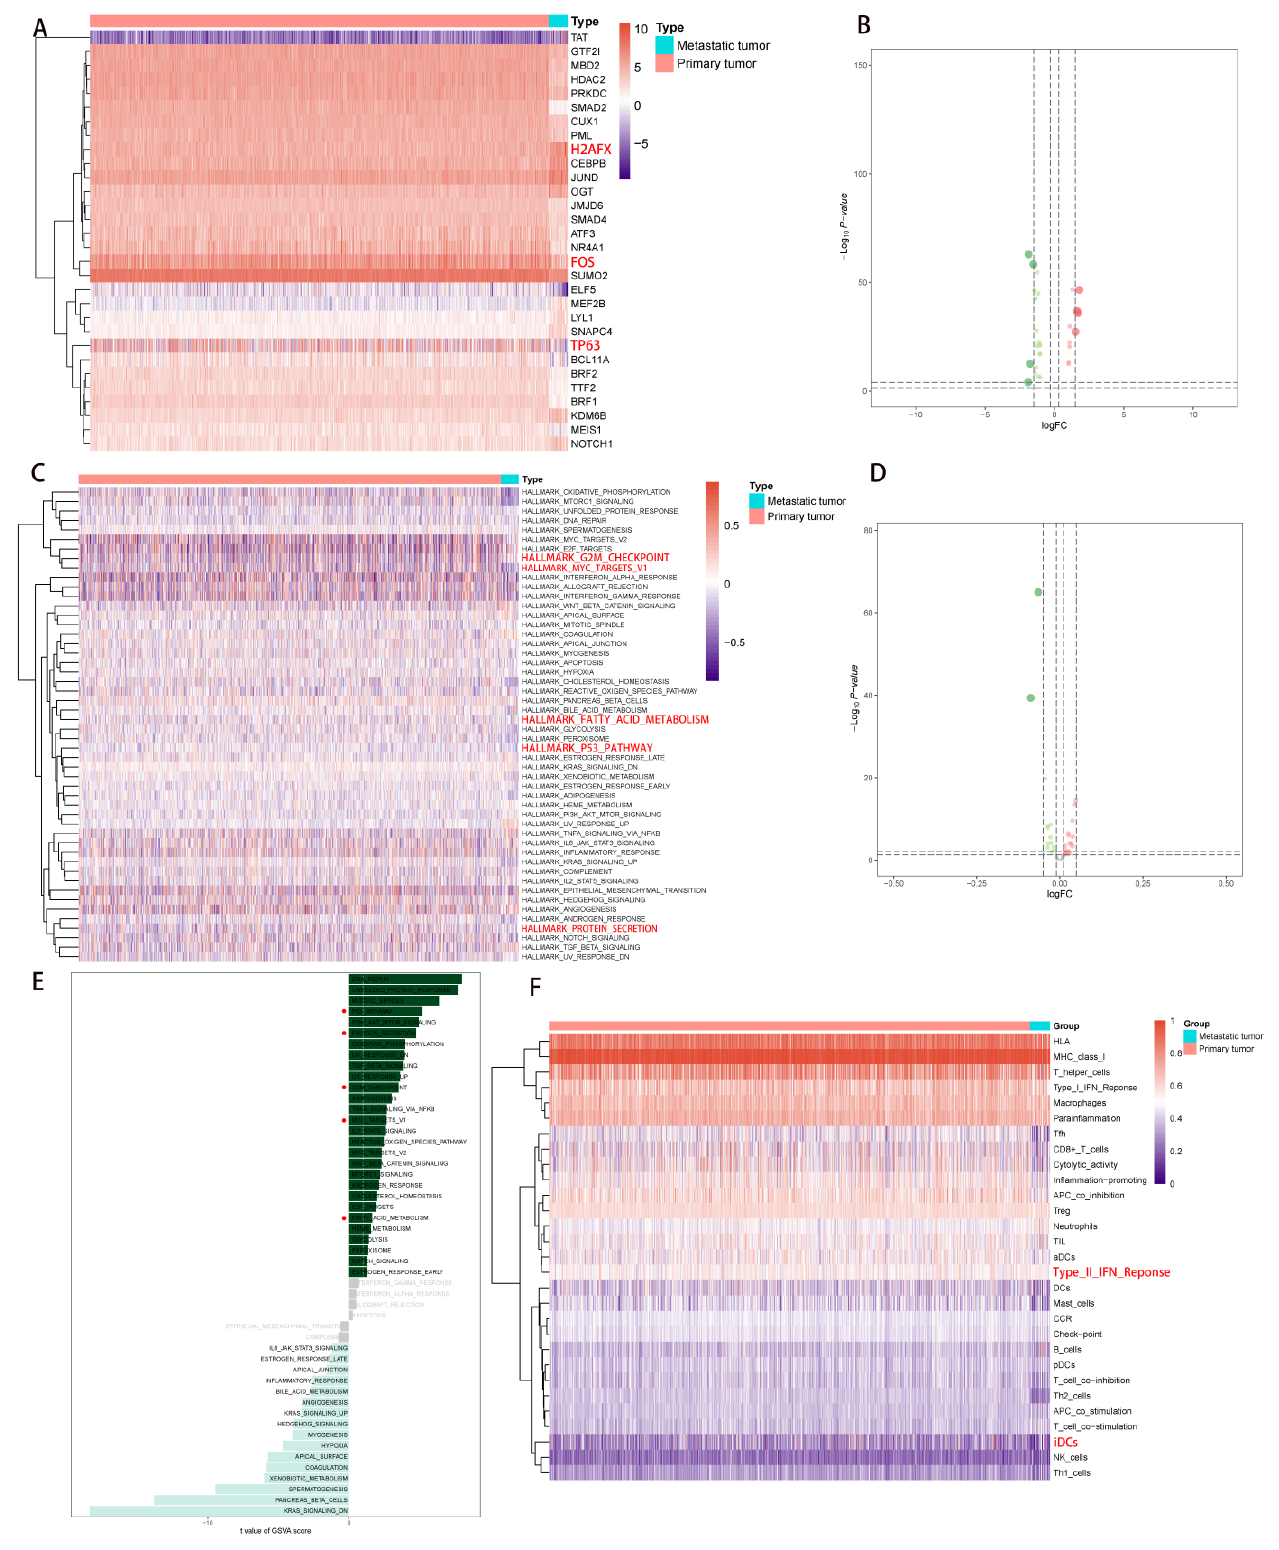
Figure 5. Differential expression analysis among TFs, 50 cancer-related hallmark signaling pathways and 29 immune-related gene sets. ( A , B ) Differential expression analysis of TFs. Thirty-one differentially expressed TFs were defined between primary NSCLC and metastatic NSCLC. In the heatmap plot ( A ), red color represented primary NSCLC and blue color represented metastatic NSCLC. In the volcano plot ( B ), red dot represented upregulated TFs and green dot represented downregulated TFs, the two dashed horizontal lines mark the positions of p value = 0.05 and p value